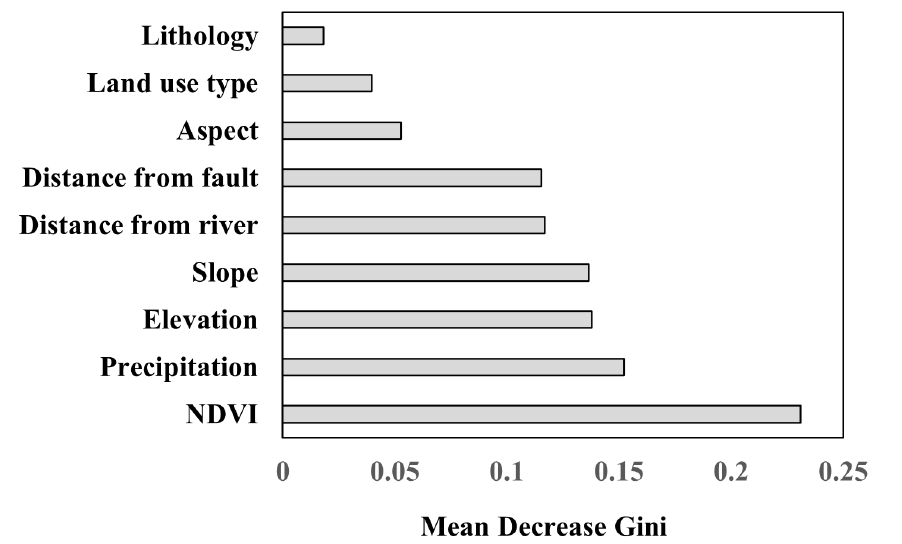
Figure 10. Mean decrease Gini of variables assigned by the random